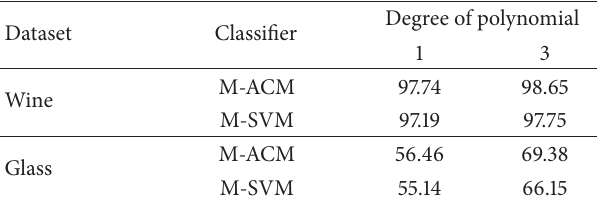
Table 1: The generalization error of MACM and